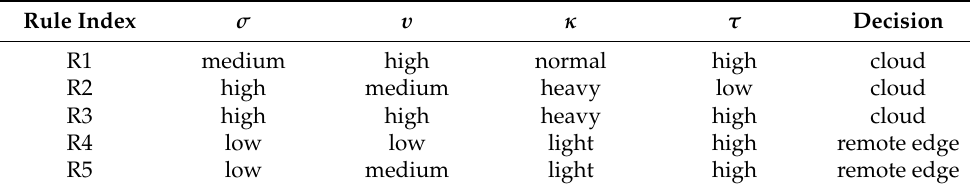
Table 4. Example of fuzzy rules for the second